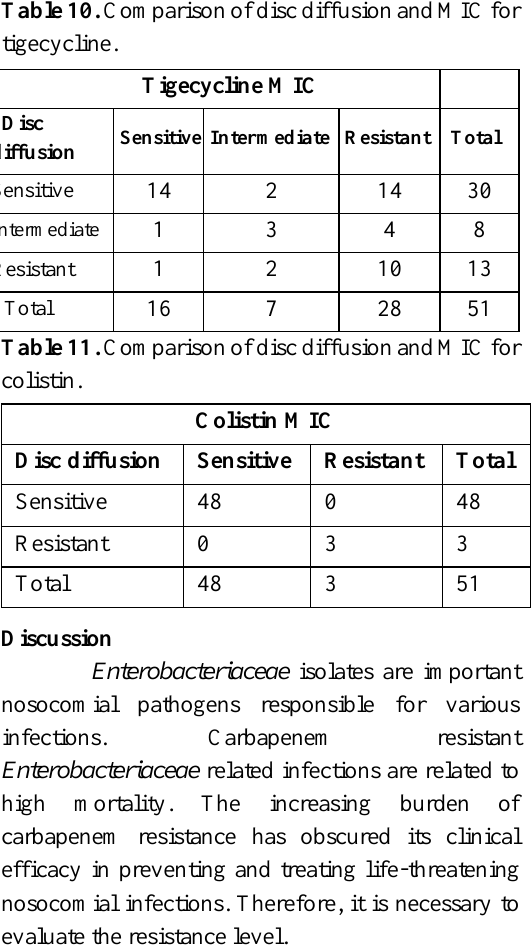
Table Enterobacteriaceae.